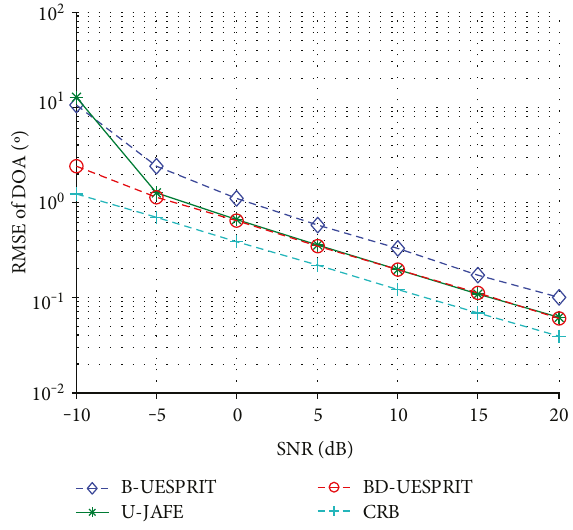
Figure 6: Variation of the DOA estimation errors with SNR for various